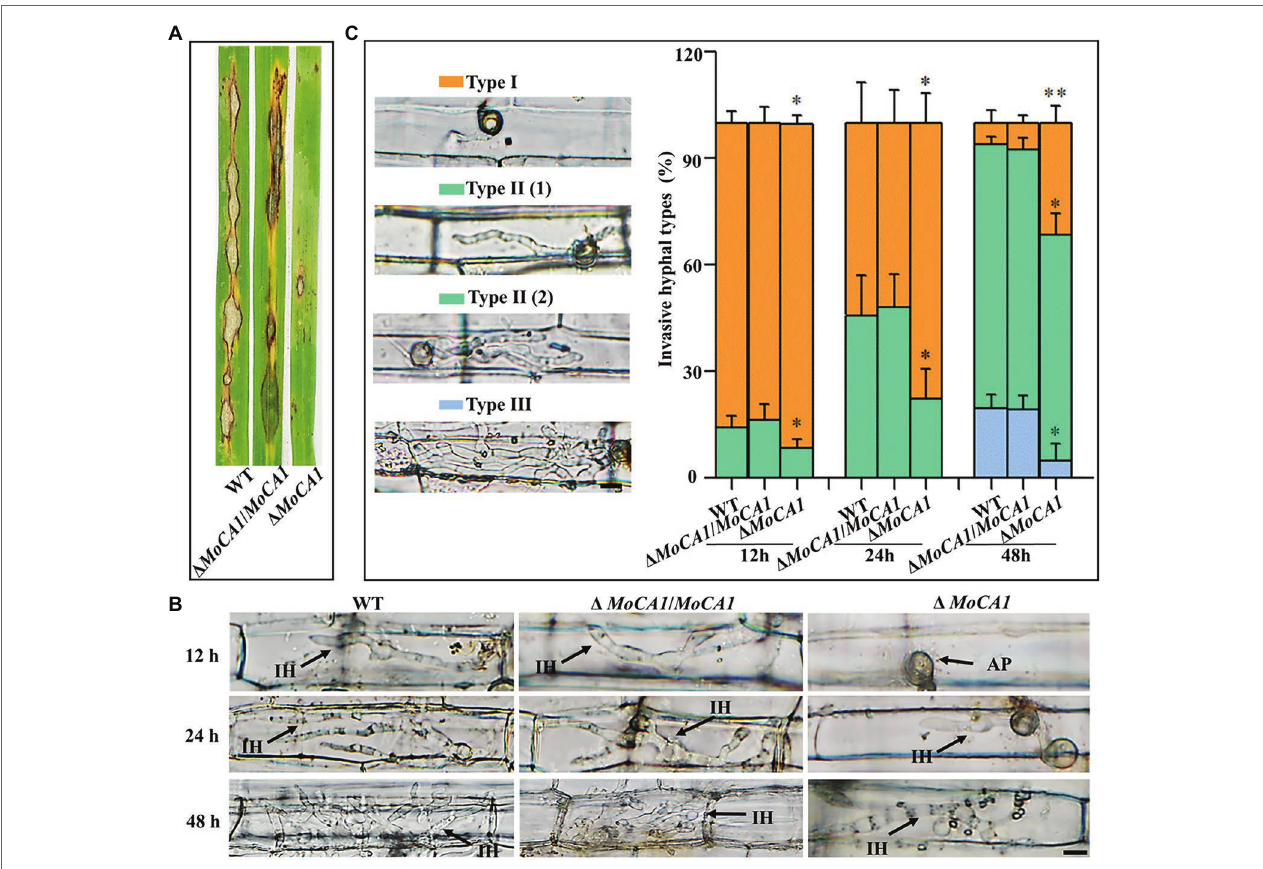
FIGURE 4 | Pathogenesis analysis of the wild-type and created strains. (A) Spray inoculation assay. (B) Rice leaf sheath infection assay. The conidial suspension of indicated strains was injected into a rice sheath. Representative photographs of infectious hyphae were taken after 12, 24, and 48 h of incubation at 25 ° C. Scale bar = 10 μ m. IH, infectious hyphae and AP, appressoria. (C) The infection rate was calculated according to the number of type I to type III events. The infection status of more than 100 germinated conidia per leaf sheath was scored at 12, 24, and 48 hpi. Type I, conidia with mature appressoria; Type II, primary hyphae formed, infectious hyphae extended and branched in one cell; Type III, infectious hyphae crossing to neighboring cells. Values represent the averages of five measurements ± SD. The statistical analysis was performed using a one-way ANOVA with Tukey’s multiple comparison test. The averages were taken from the quadruplicate analysis. Values are based on three biological samples, and error bars indicate SD, * p < 0.05 and ** p <